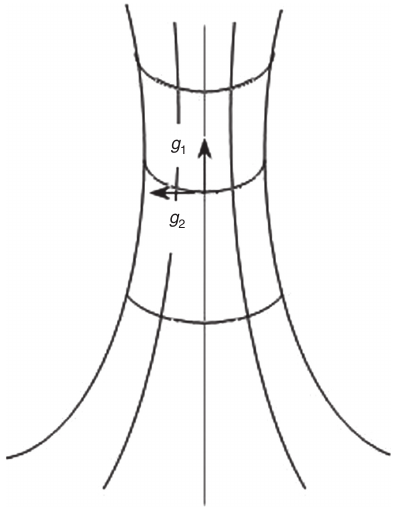
Figure 6 The principal curvature coordinate